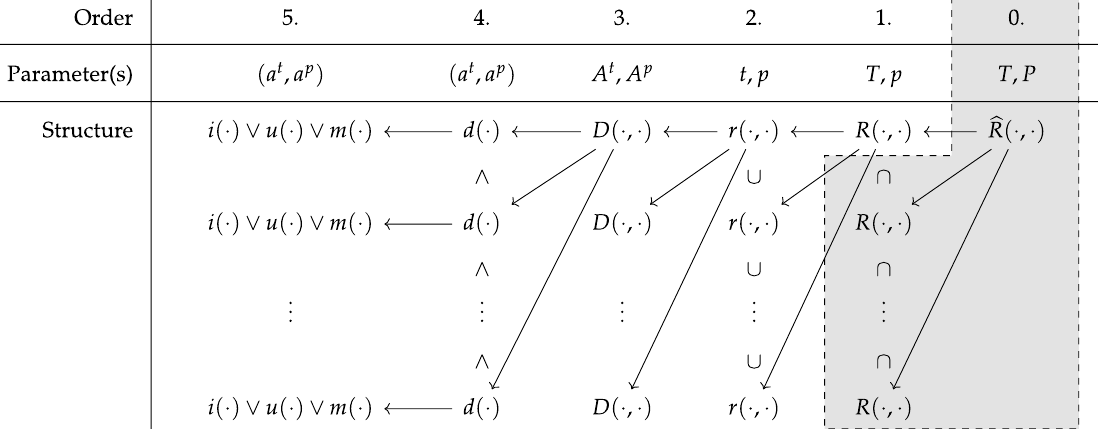
Figure 8. Illustration of function calls with parameterization of the formally described decision making process for a single particle type (excluding the gray area), respectively for multiple particle types (including the gray